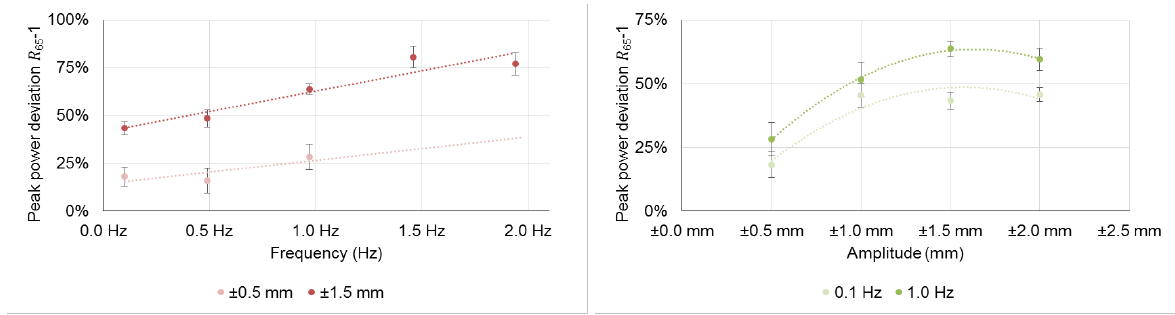
Figure 5. Deviation of noise level in detector 6 with respect to detector 5, as a function of frequency for two amplitudes (left, red), and as a function of amplitude for two frequencies (right, green). The fitting curves are indicated for illustrative